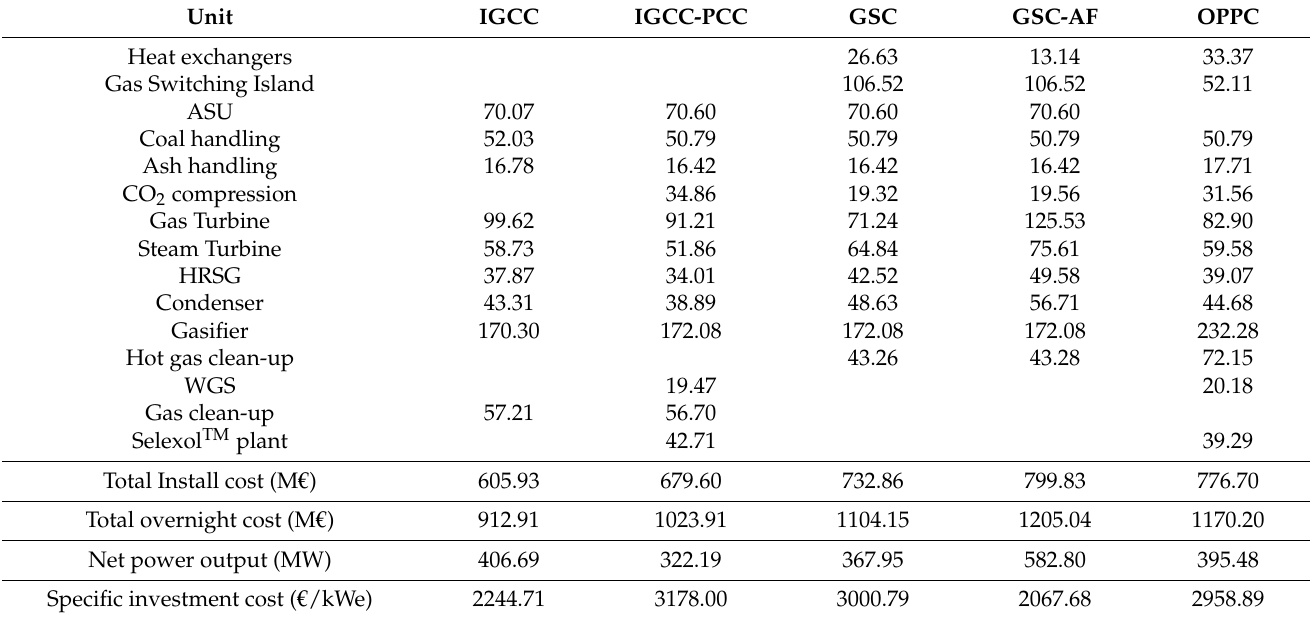
Table 7. Installed costs for the main process components in each case.